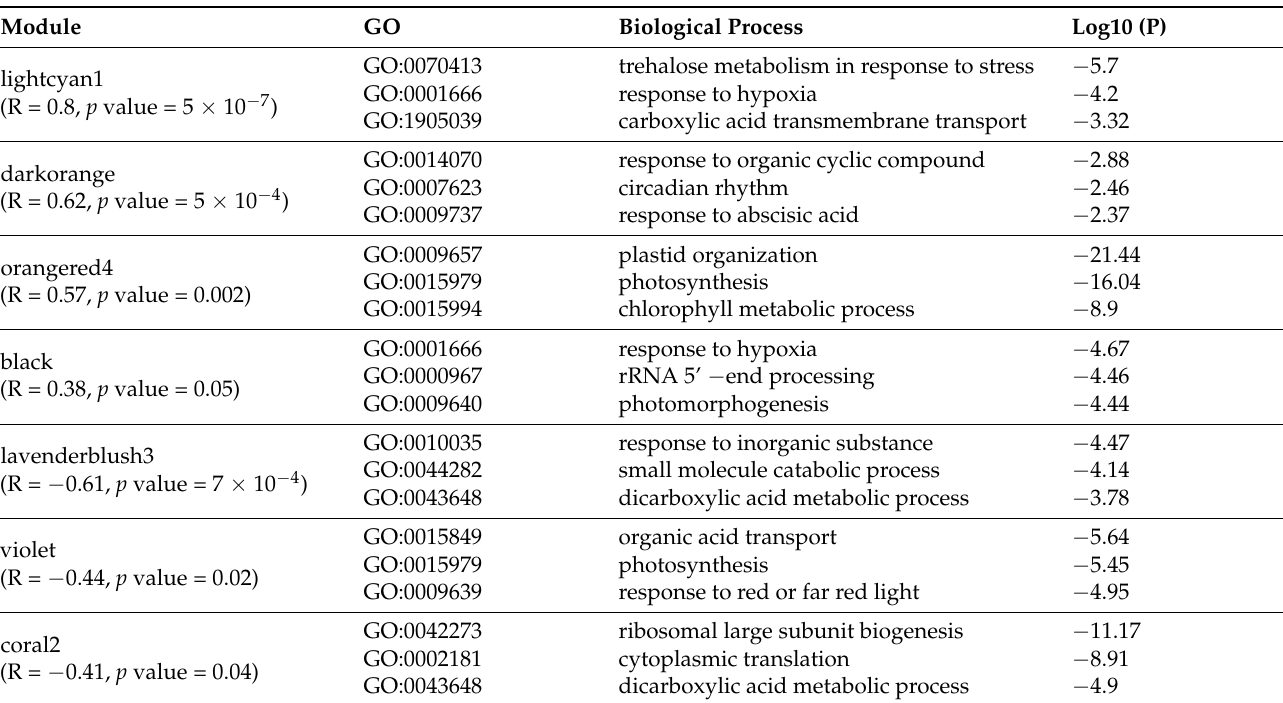
Table 1. Gene ontology terms enriched for biological processes using the Mg 2+ concentration associ- ated modules DEGs in leaves.